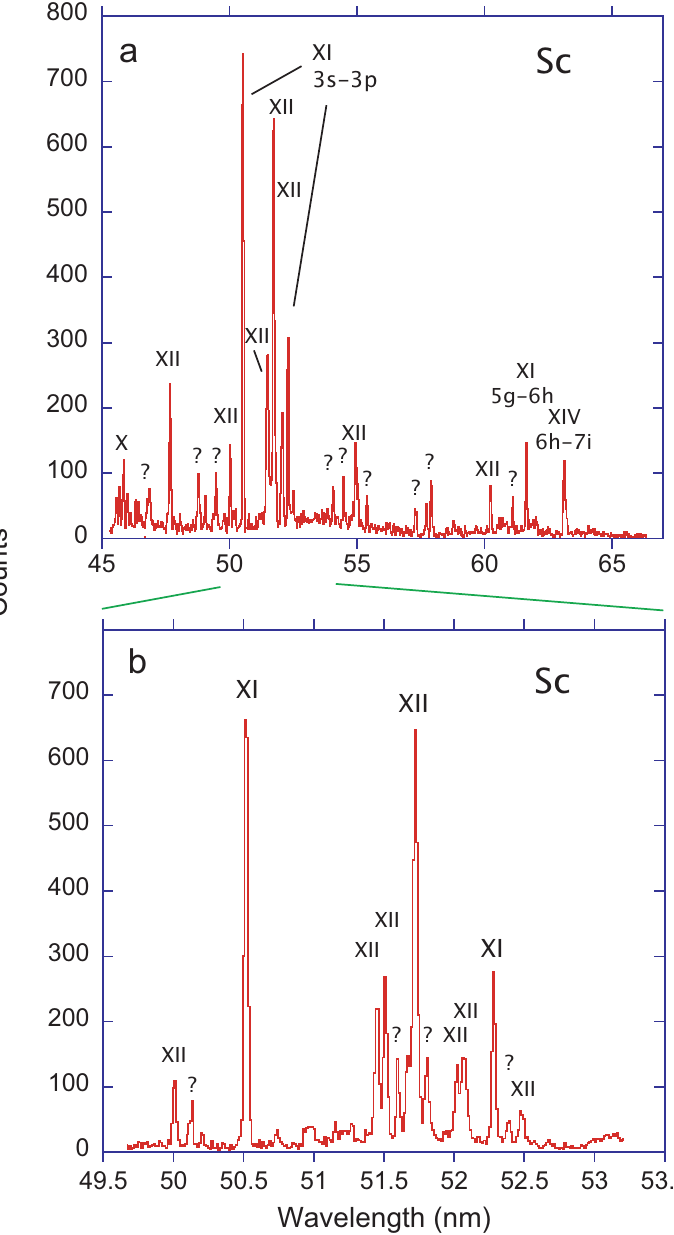
Figure 7. Beam-foil spectra of Sc recorded at an ion beam energy of 23MeV. The strongest lines are identified by the spectrum number. Observation at the foil. ( a ) Line width (FWHM) 0.06nm. ( b ): Detail spectrum ( b ) recorded at higher resolution (line width (FWHM) 0.03nm). The wavelength interval of ( b ) is indicated relative to ( a ) in between the plots. Prominent ScXII lines [37] lie in between the resonance lines of ScXI and reach a similar